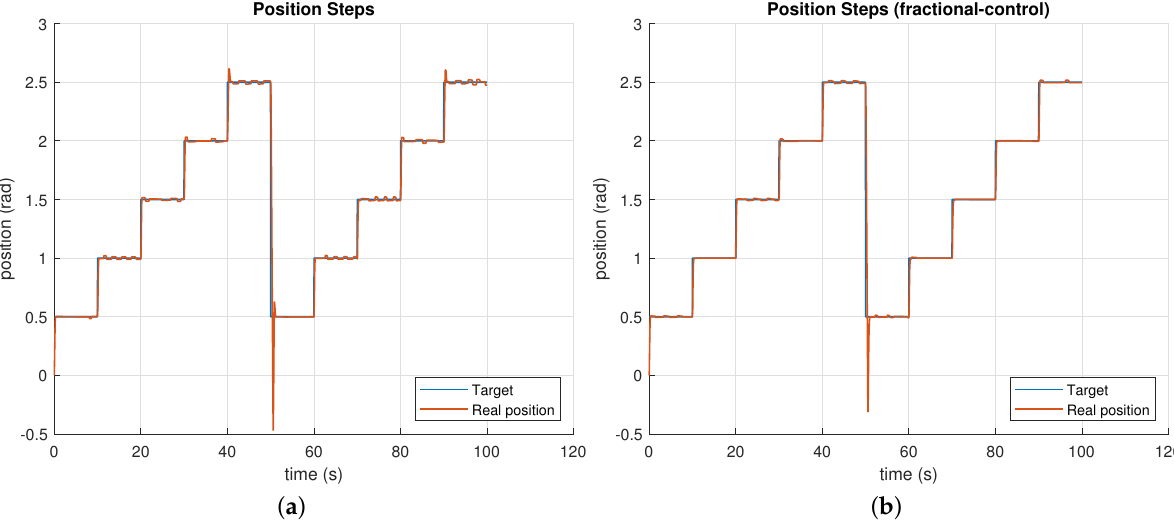
Figure 22. Test results with sequential target positions. ( a ) Integer controller. ( b ) Fractional controller.